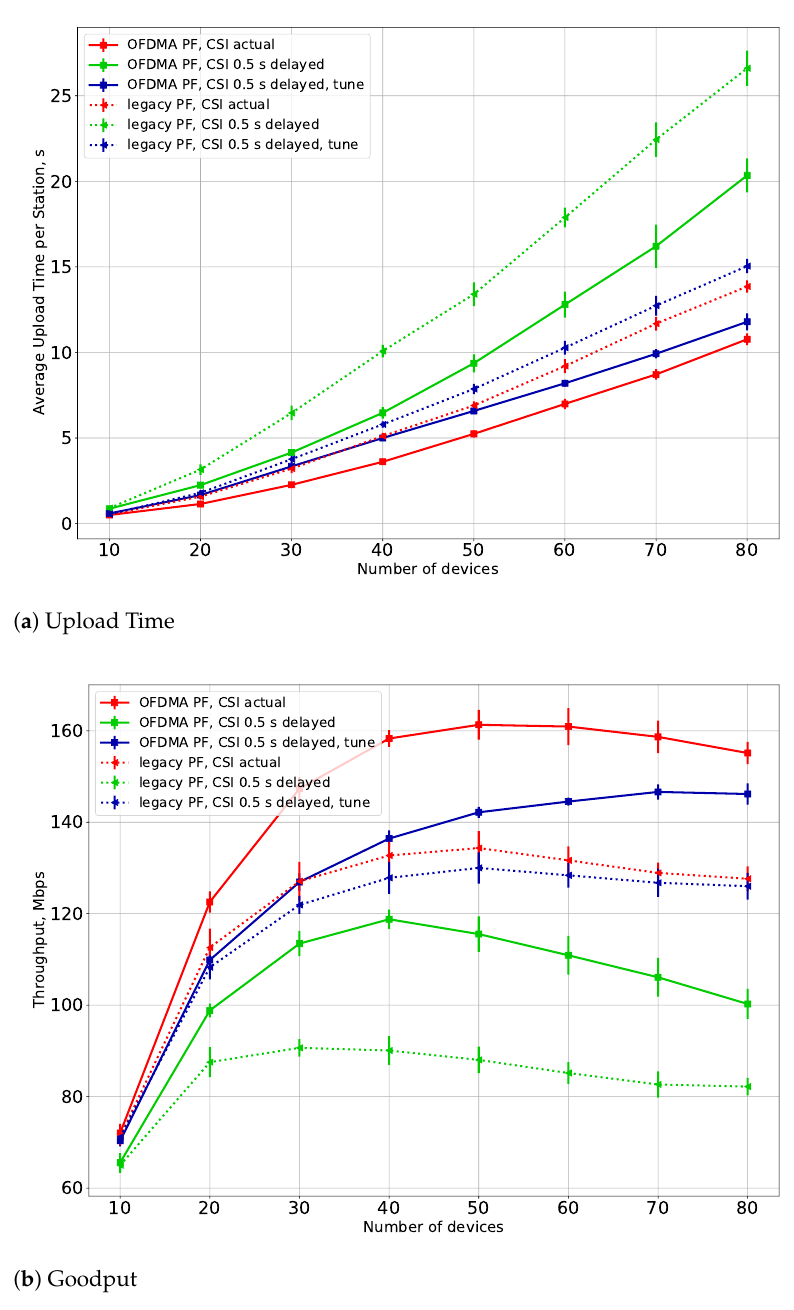
Figure 7. ( a ) Upload time and ( b ) goodput for the CSI Adaptation Algorithm for FS-PF. We also investigate the effect of the power supplement described in Section 6.2. In this series of experiments, we also place three APs with R AP = 20 m and fix the total number of STAs N = 50. The dependencies of the upload time and the goodput on the P sup parameter value for the greedy-PF scheduler for R = 20 m and R = 40 m (MR and SRPT have similar results) are shown in Figures 8 and 9. For the R = 20 m case, power supplement only worsens the performance because of the maximum power difference constraint and because the STAs are located not so far from each other. However, for the R = 40 m case, increasing the transmit power has a beneficial effect on performance. Such an effect happens due to the interference at the AP from far devices that are not